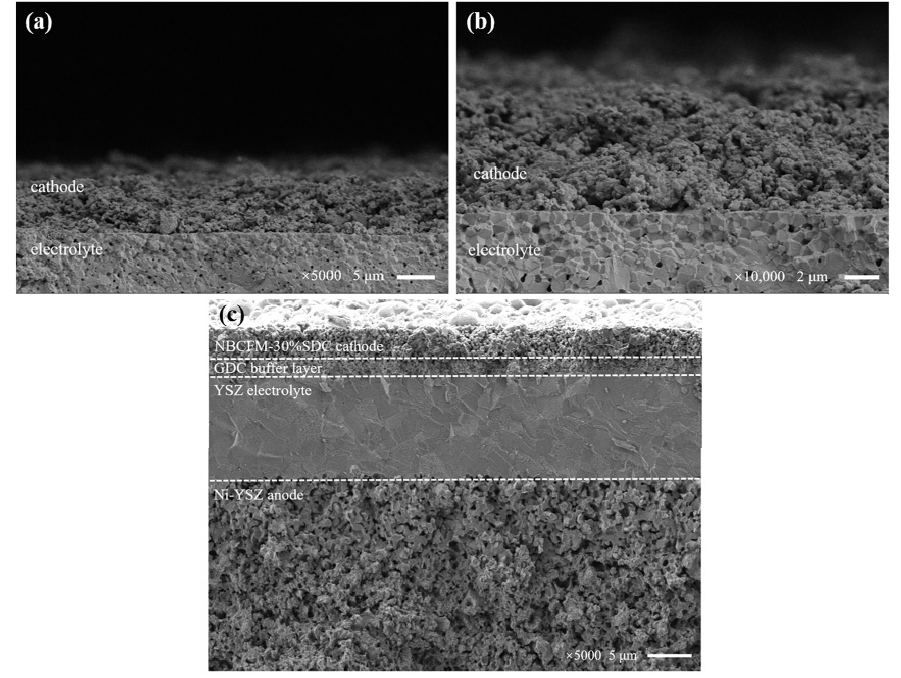
Figure 10. SEM micrograph interface-view for ( a , b ) NBCFM-30%SDC/SDC cathodes, and ( c ) Ni- YSZ/YSZ/GDC/NBCFM-30%SDC single cell after cell